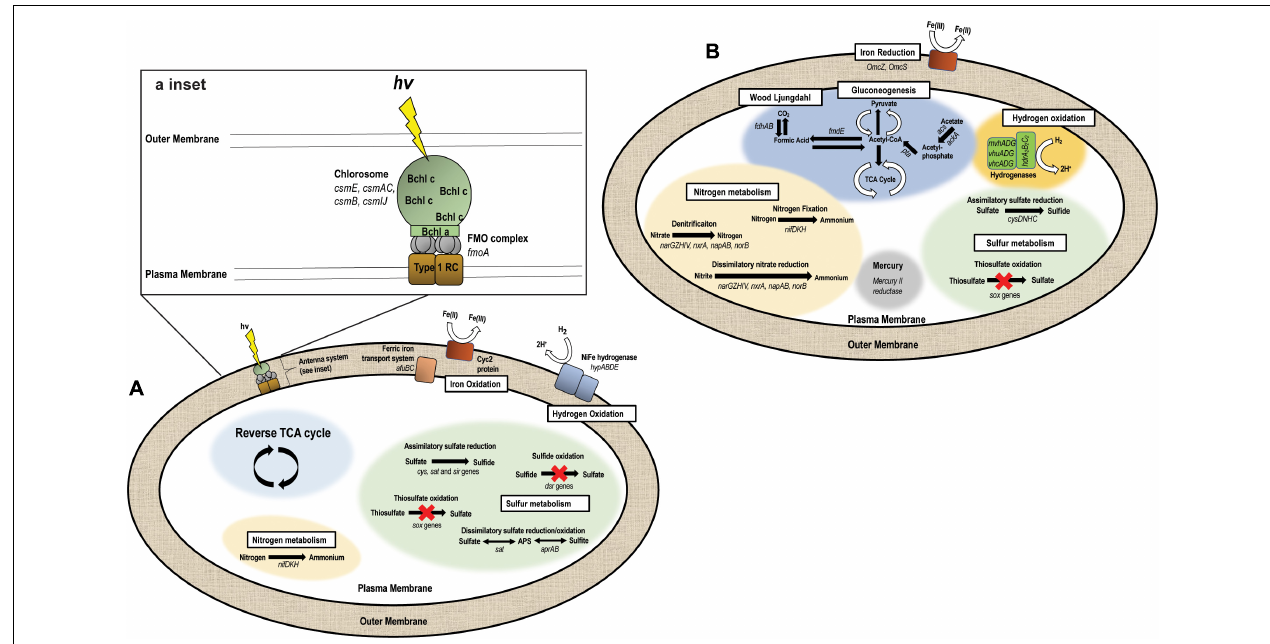
FIGURE 5 | Metabolic pathways encoded by the two genomes recovered from the BLA1 enrichment. (A) “ Ca. C. masyuteum” (APS—adenylyl sulfate). Inset shows the antenna system (RC—reaction center, FMO—Fenna–Matthews–Olson, Bchl—Bacteriochlorophyll). (B) “ Ca. P.